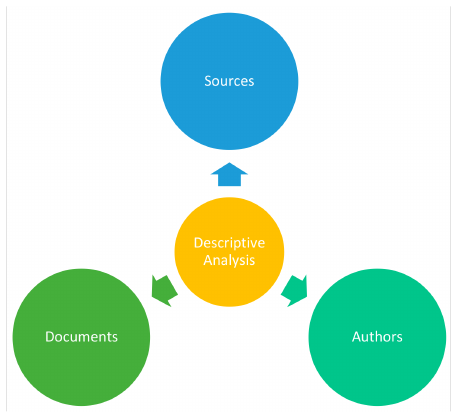
Figure 5. Descriptive